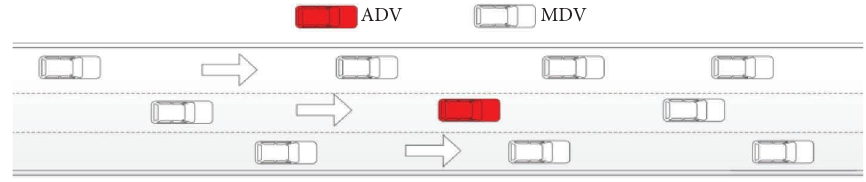
Figure 2: Multilane highway